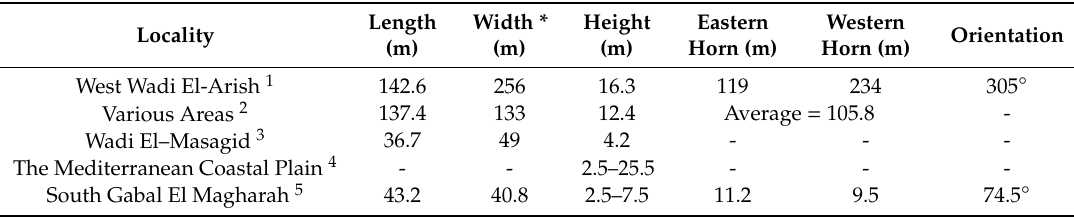
Table 4. Crescent dune dimensions in the North Sinai Sand